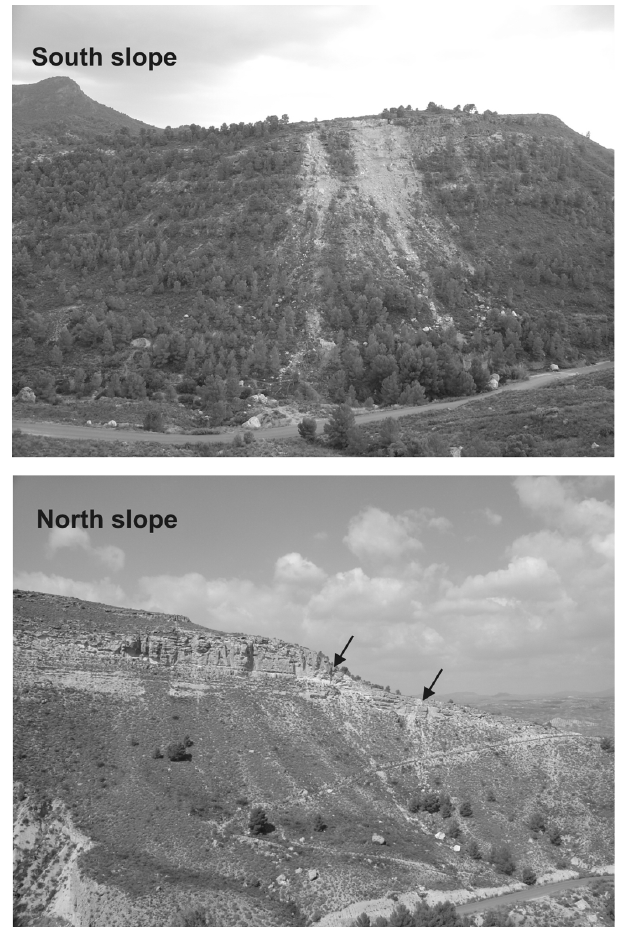
Fig. 3. Views of the studied slopes. Top: Southern slope (large fail- ures); bottom: Northern slope (small failures are shown by the ar- rows).